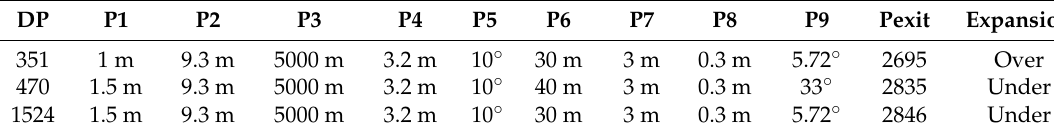
Figure 9. Static pressure distribution of SERN DP351 for 80,000 ft. ( top ) and 100,000 ft. ( bottom ). Table 6. SERN geometries for different design points (DPs).